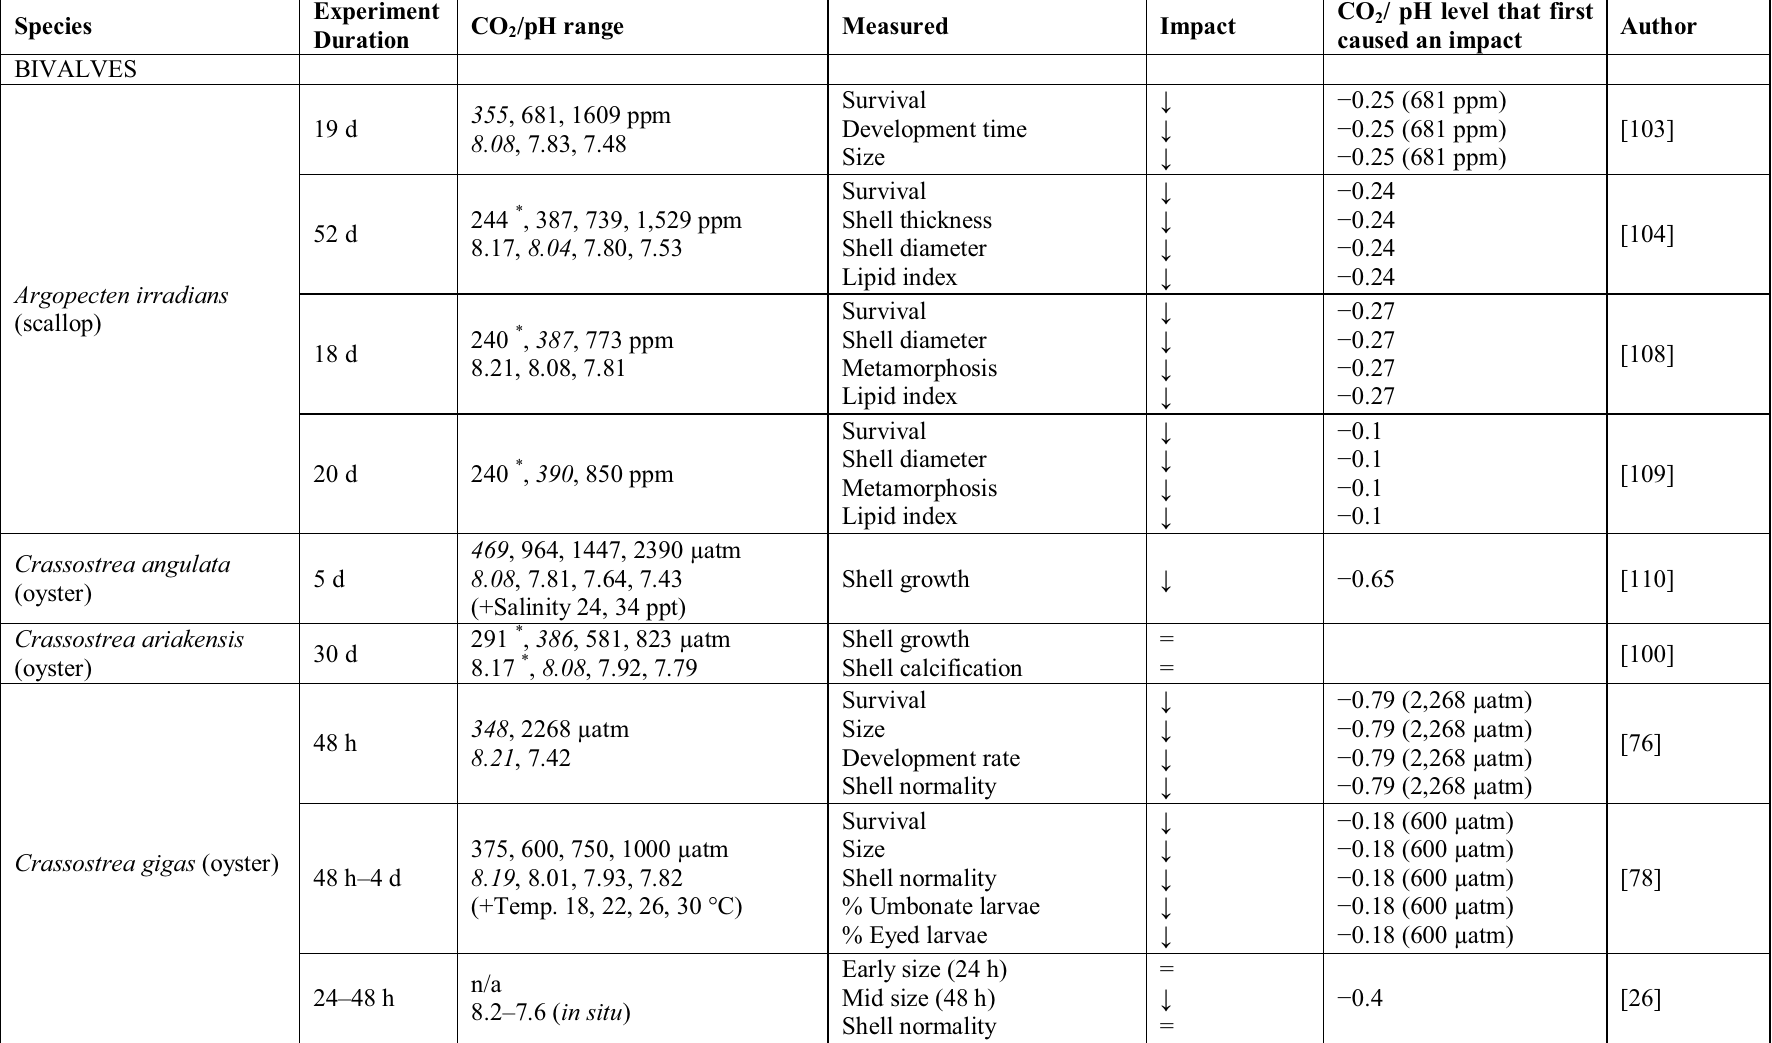
Table 3. Summary of the impacts of ocean acidification on embryonic and larval development of molluscs.